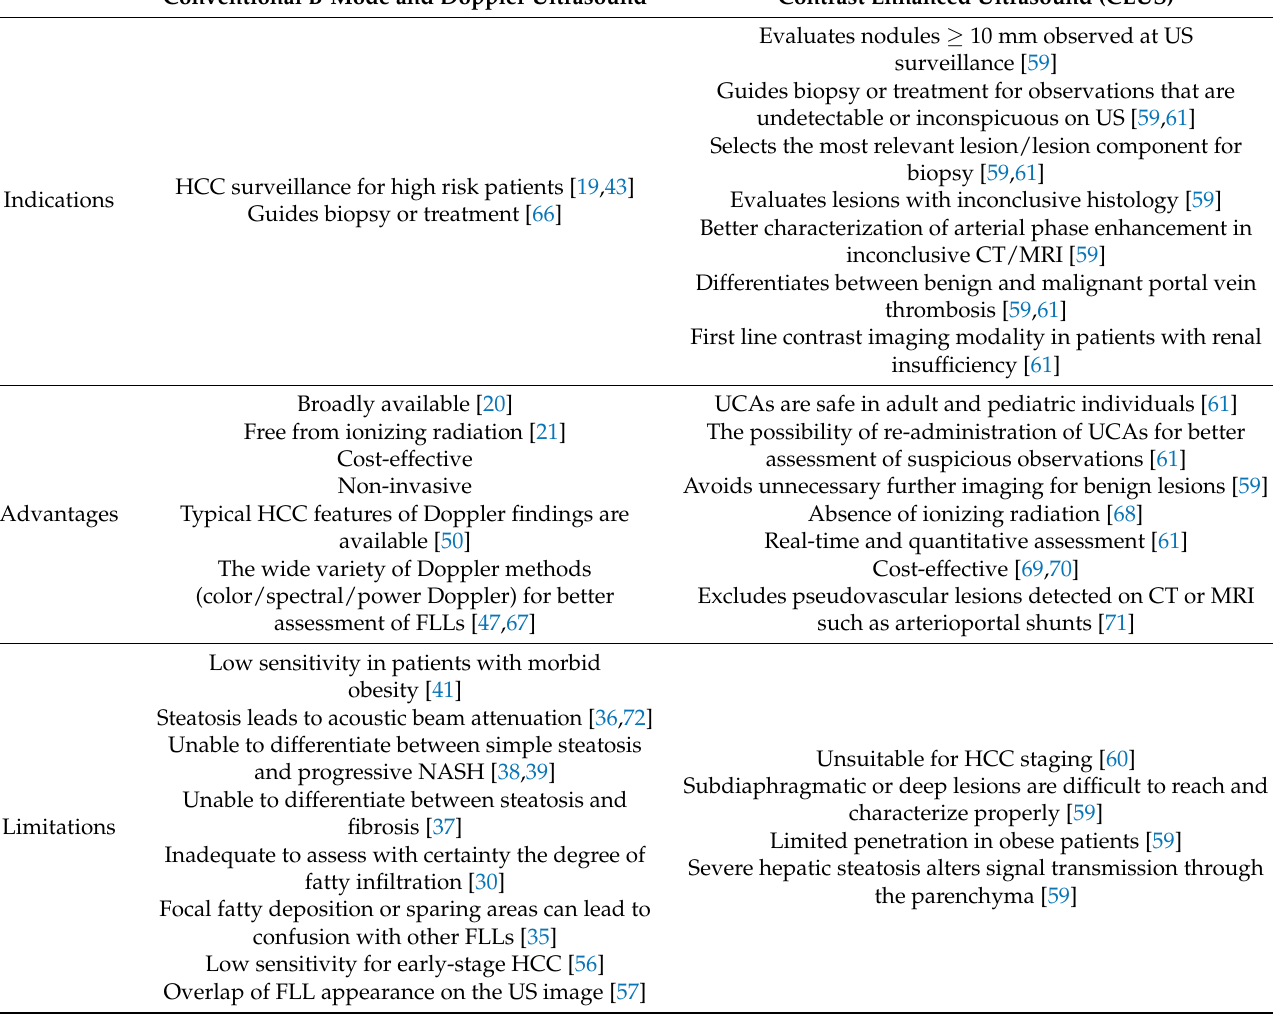
Table 2. Indications, advantages, and limitations of CEUS as compared to B-mode and Doppler US. Conventional B-Mode and Doppler